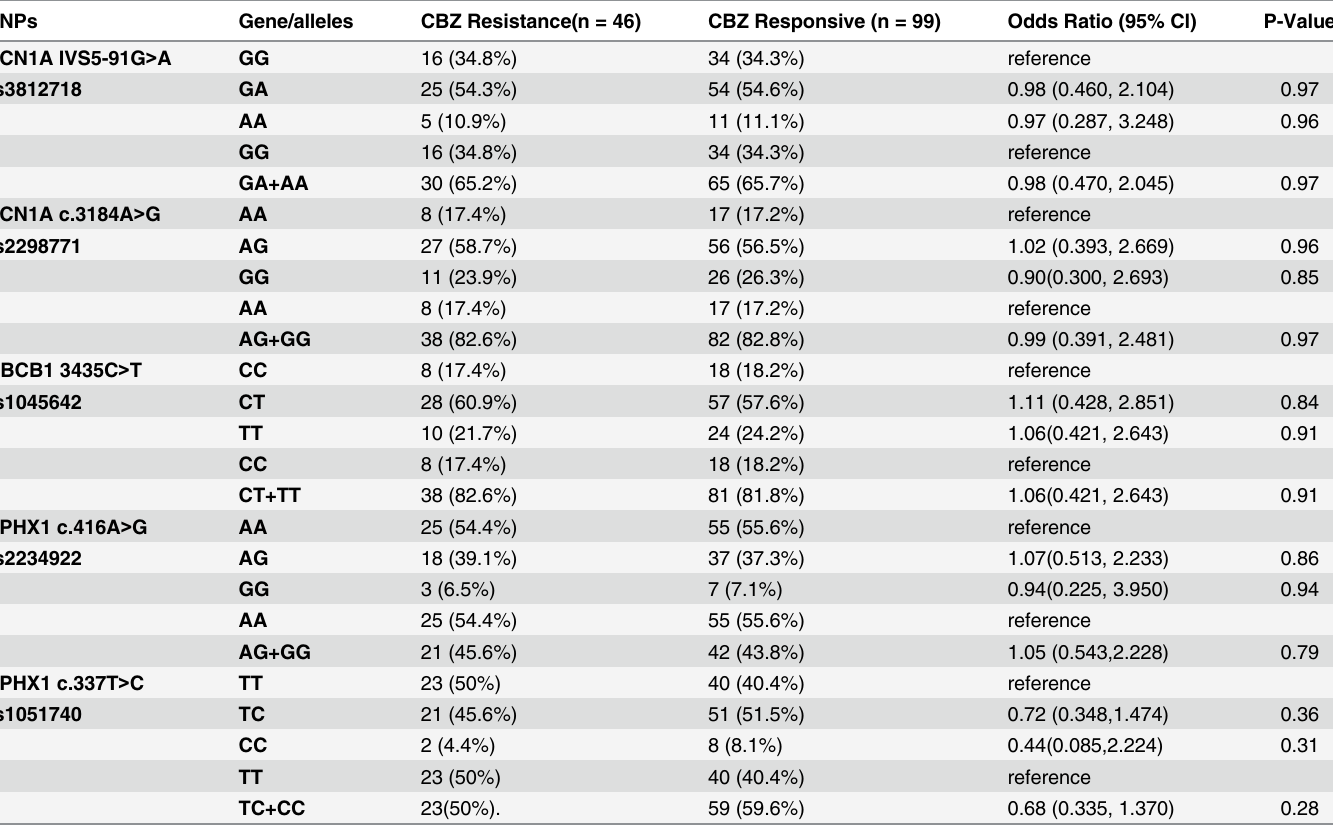
Table 3. Distribution of SCN1A, ABCB1, EPHX1 genes polymorphism in drug-resistant and drug-responsive epileptic patients.